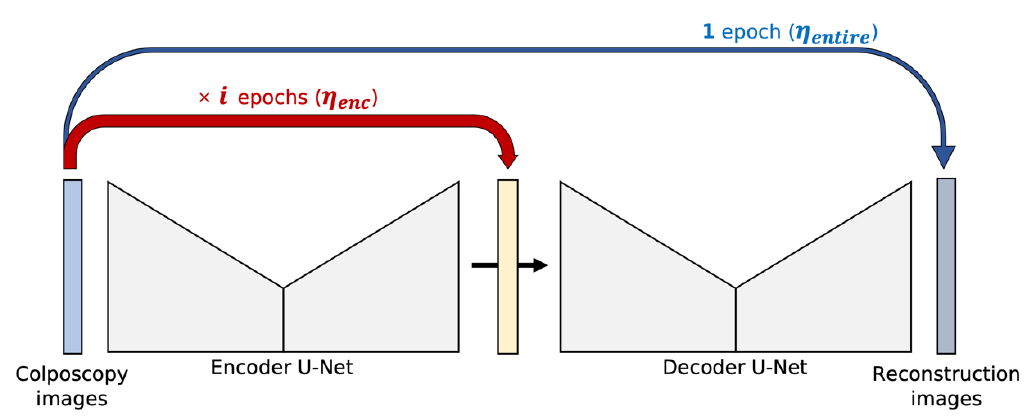
Figure 2. Proposed encoder-weighted learning scheme.